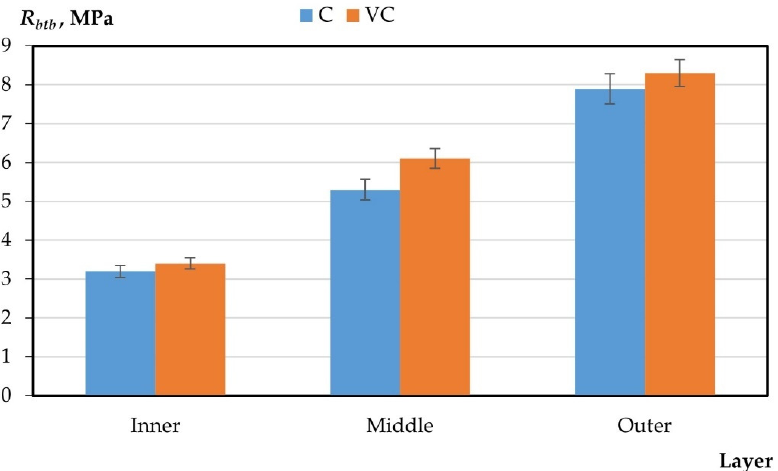
Figure 7. Change in tensile strength in bending by layers (C—centrifuged concrete, VC— vibrocentrifuged